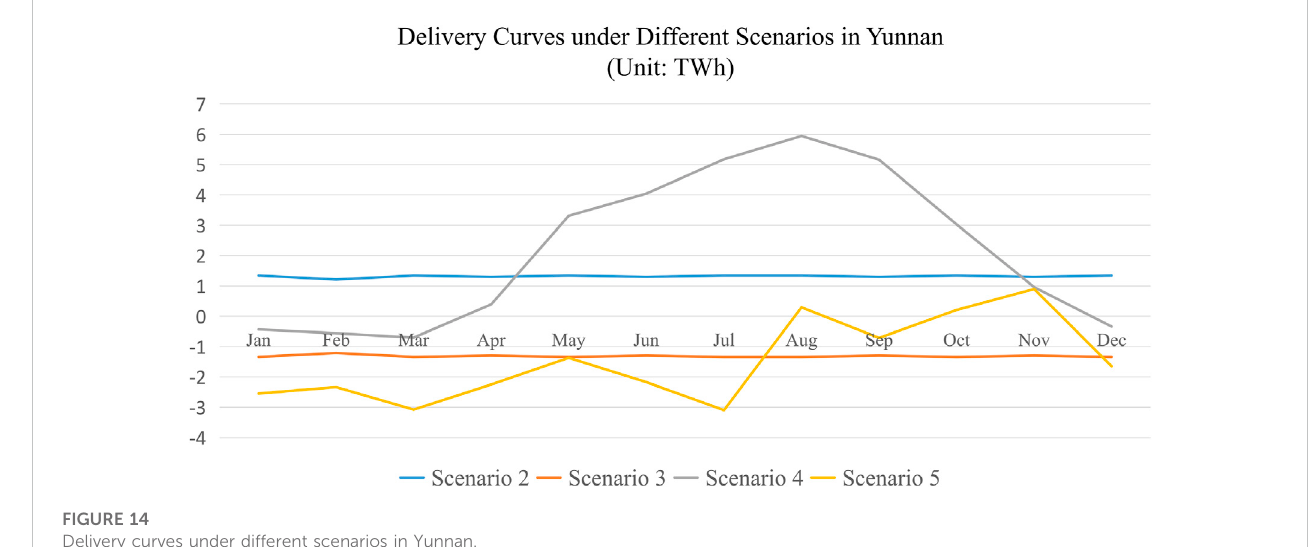
FIGURE 14 Delivery curves under different scenarios in Yunnan.